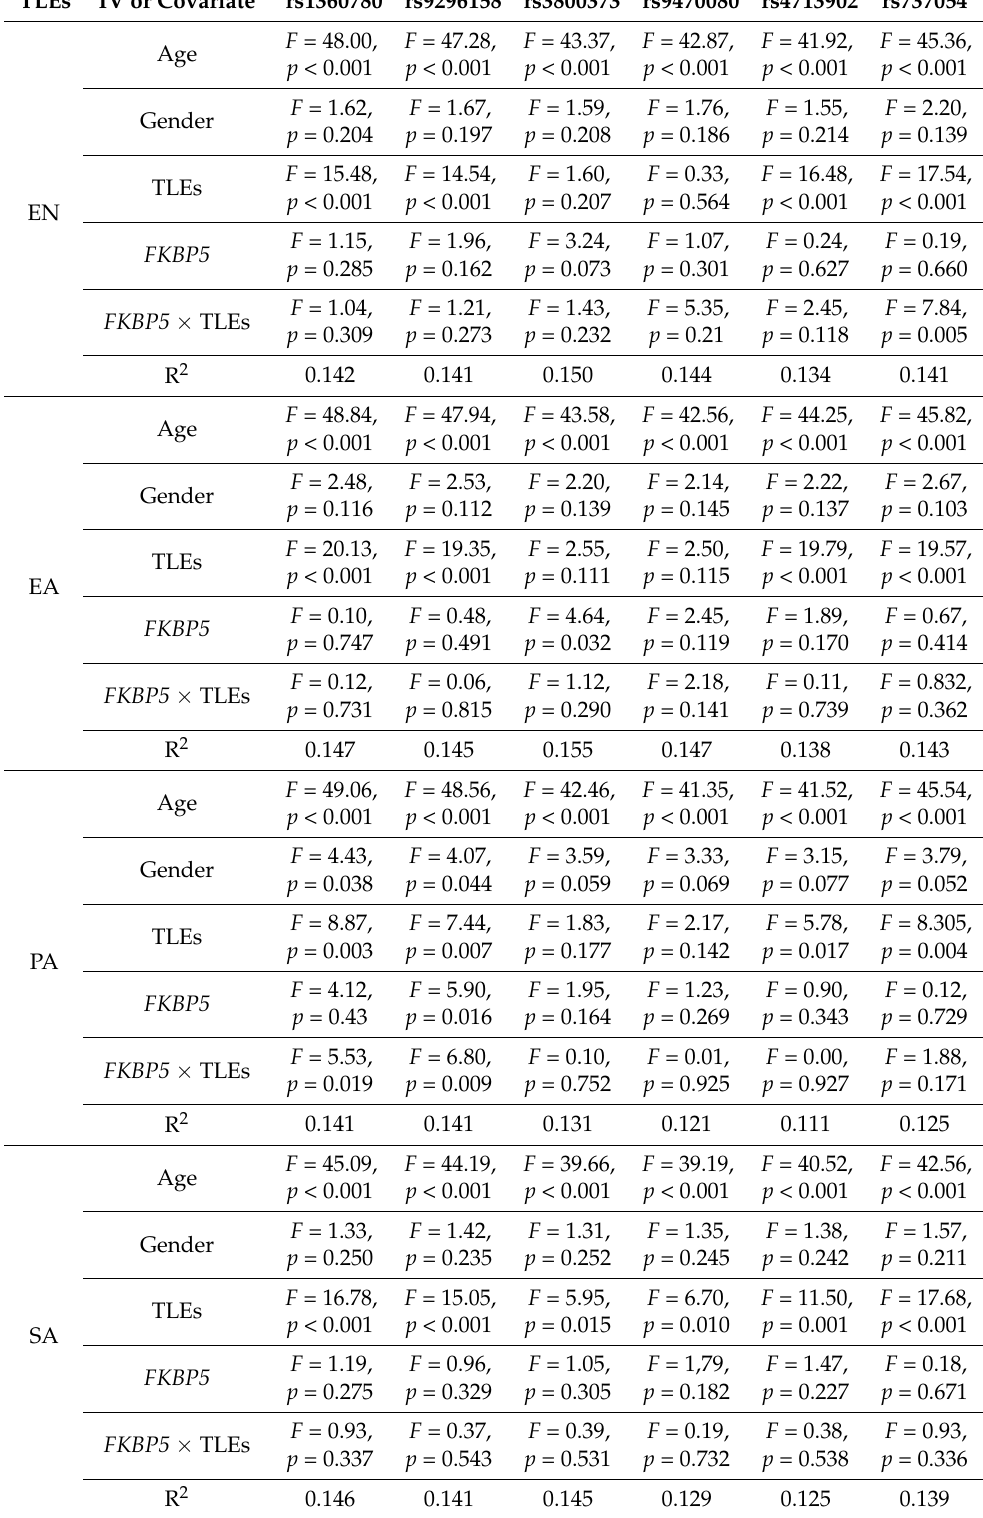
Table 3. Main and interactive effects of the FKBP5 variants on the PQ-16